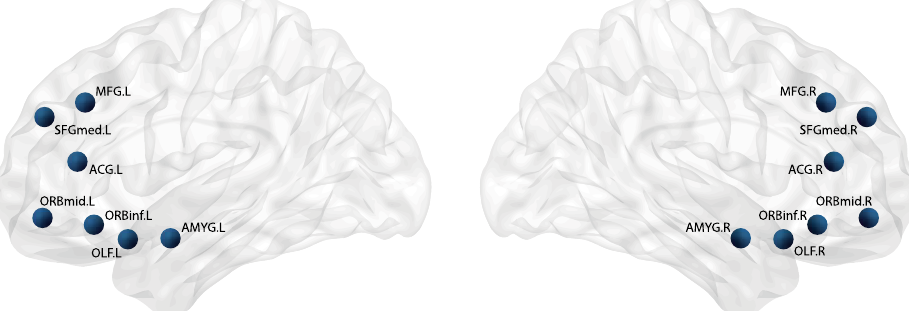
Figure 2. Location of selected AAL ROIs underlying major regions involved in olfactory, affective and reward processing. Regions comprise a total of 14 nodes: The middle frontal gyrus (MFG L/R ), the superior frontal gyrus, medial part (SFGmed L/R ), the anterior cingulate gyrus (ACG L/R ), the mid- dle frontal gyrus, orbital part (ORBmid L/R ), the inferior frontal gyrus, orbital part (ORBinf L/R ), the olfactory cortex (OLF L/R ) and the amygdala (AMYG L/R